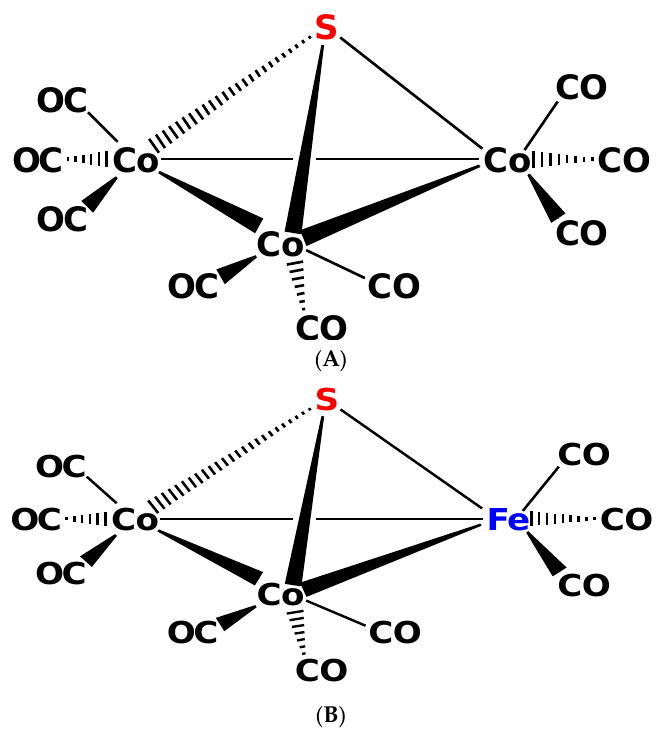
Figure 3. Schematic view of the structure ( A ) of complex 4 [19,20]; Schematic view of the structure ( B ) of complex 5 [21].